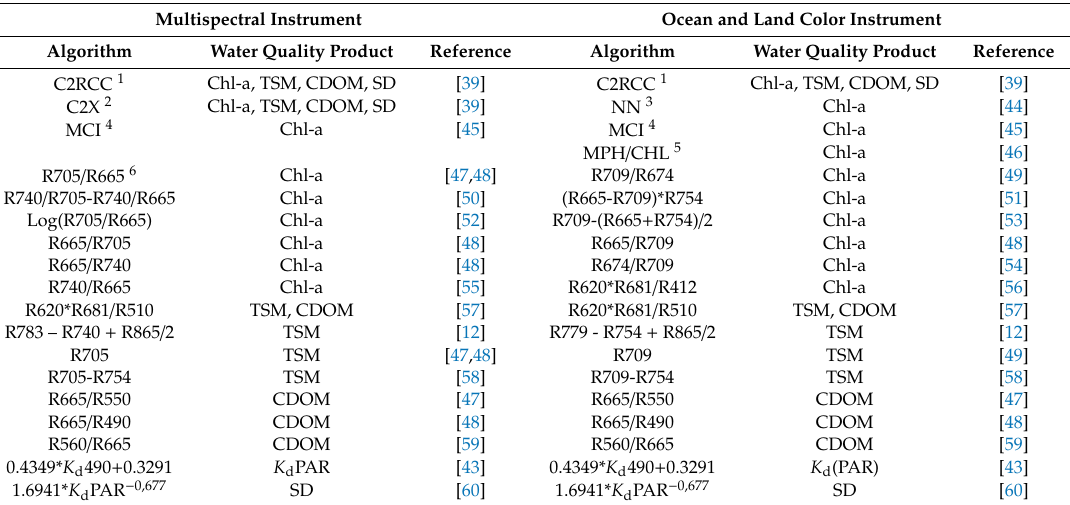
Table 1. Used algorithms to retrieve the water quality products: chlorophyll-a (Chl-a), total suspended matter (TSM), absorption of colored dissolved organic matter (CDOM) at 400, 412, and 442 nm, Secchi depth (SD), and light attenuation coe ffi cient over 400–700 nm ( K d PAR). R in band ratio algorithms notes the reflectance at given